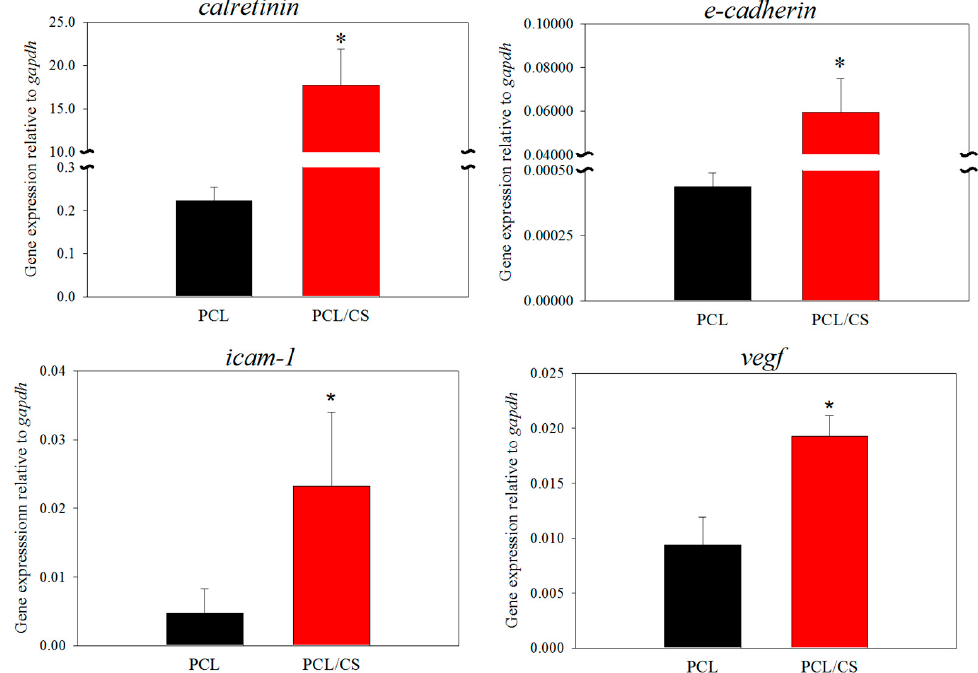
Figure 7. The relative gene expression level of calretinin, E-cadherin, intercellular adhesion molecule (ICAM-1) and vascular endothelial factor (VEGF) by mesothelial cells was determined by quantitative real-time polymerase chain reaction (qRT-PCR) after culture for 7 days in PCL and PCL/CS nanofiber membranes. Glyceraldehyde 3-phosphate dehydrogenase (GAPDH) was used for the quantification. * p < 0.05 compared with PCL.